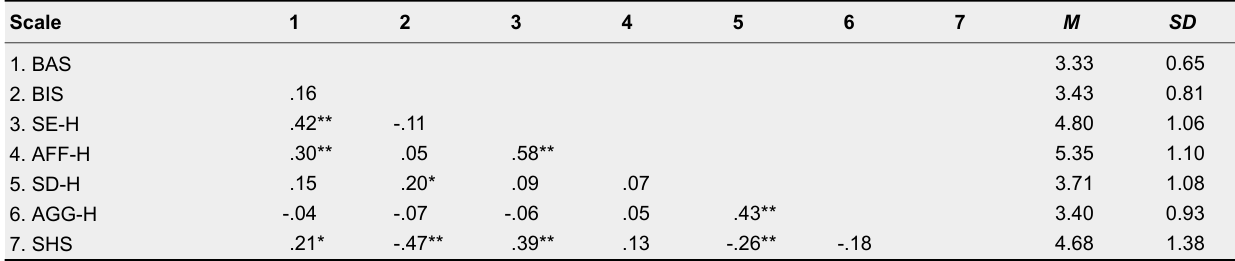
Correlations and descriptive statistics for the BAS, BIS, self-enhancing humor style (SE-H), affiliative humor style (AFF-H), self-defeating humor style (SD-H) and aggressive humor style